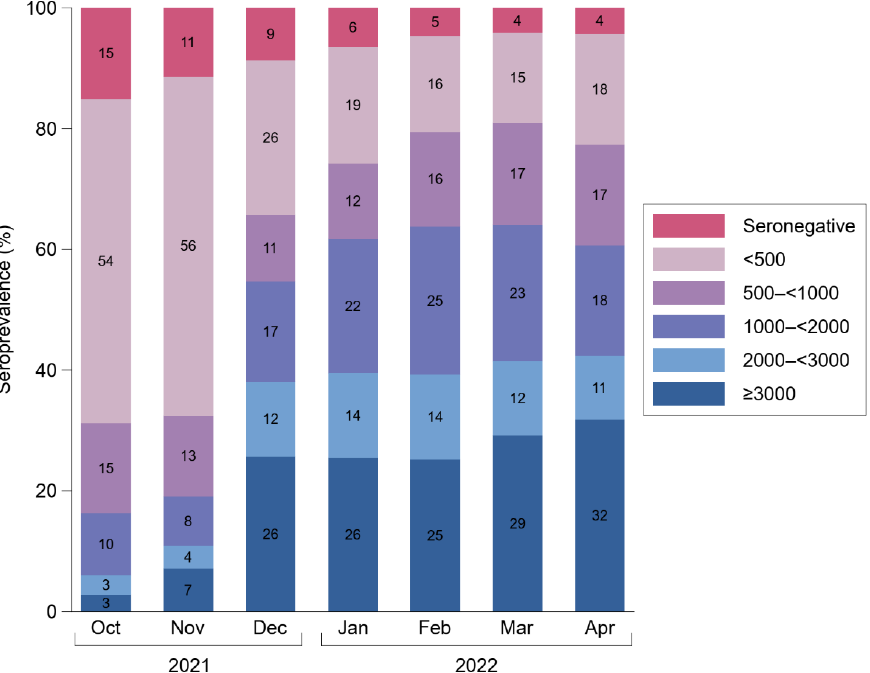
Figure 1. Percentage of participants in categories of anti-S IgG antibody levels in Binding Antibody Units per milliliter between October 2021 and April 2022. Seronegativity corresponds to anti-S IgG levels < 7.1 Binding Antibody Units per milliliter. The analysis involved data on 25,561 measurements taken from 22,607 individuals.